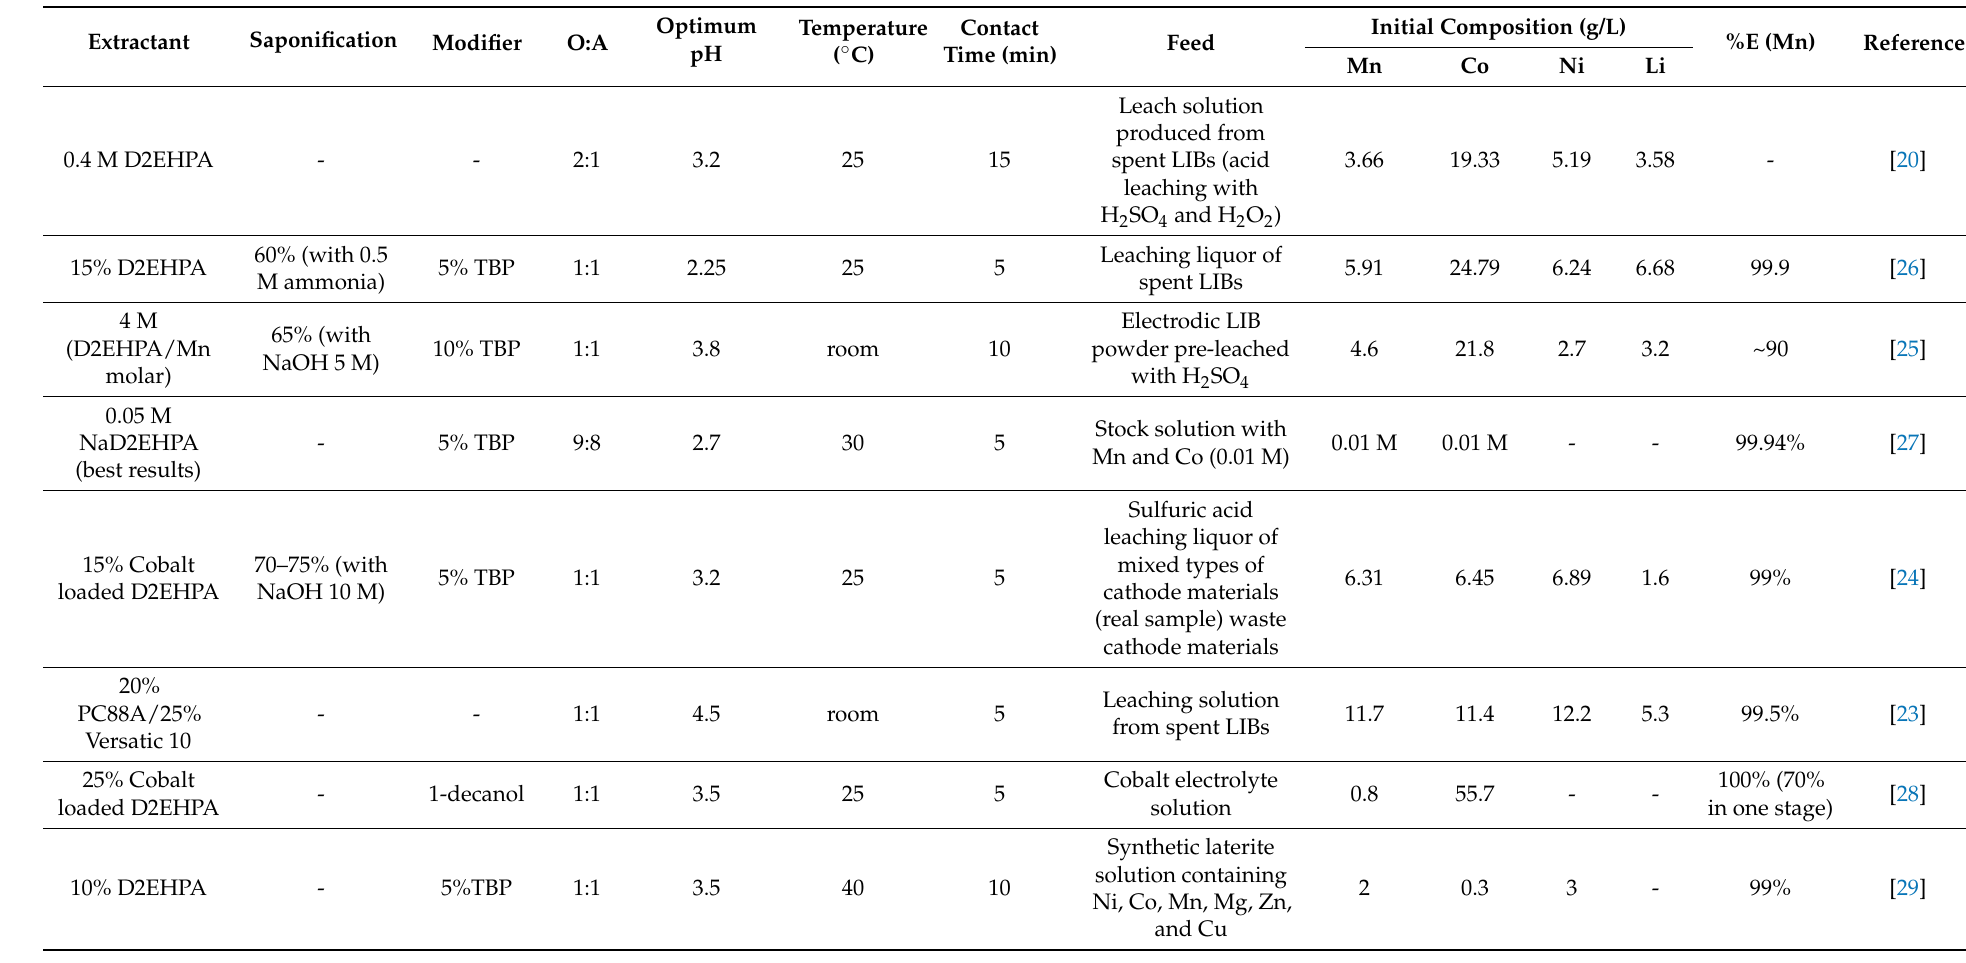
Table 1. Summary of conditions for the manganese solvent extraction from published studies (corresponding to the best conditions